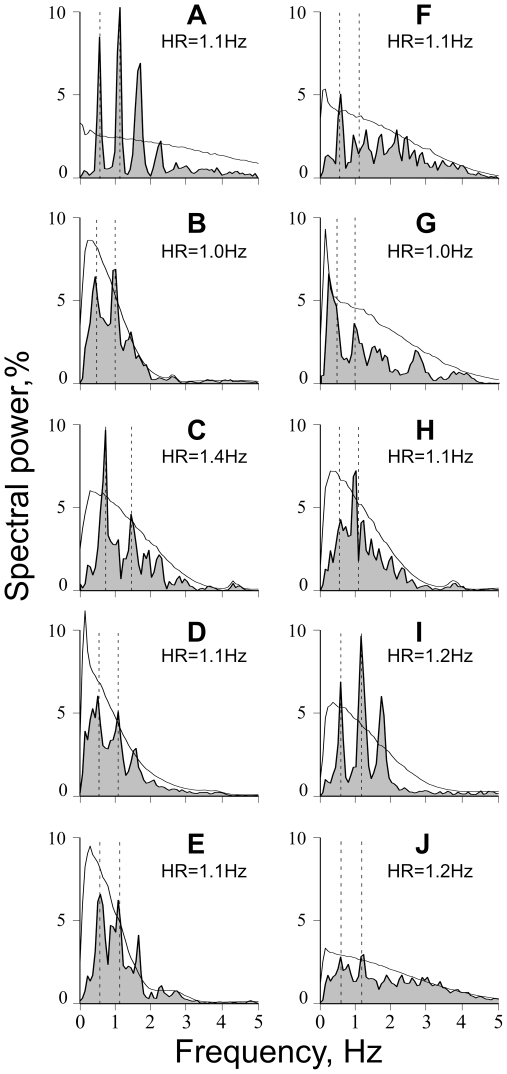
Examples of spectral analyses for the same ten afferents illustrated in 
figure 4 A–J
, respectively.The gray shaded area shows the distribution of spectral power represented as a percentage of total power. Mean heart rate (HR) is indicated by the left dashed vertical line and numeric value. The right dashed vertical line indicates the frequency twice that of the heart rate. The thin black line indicates the 95% confidence interval, determined using the surrogate power spectrum distribution.